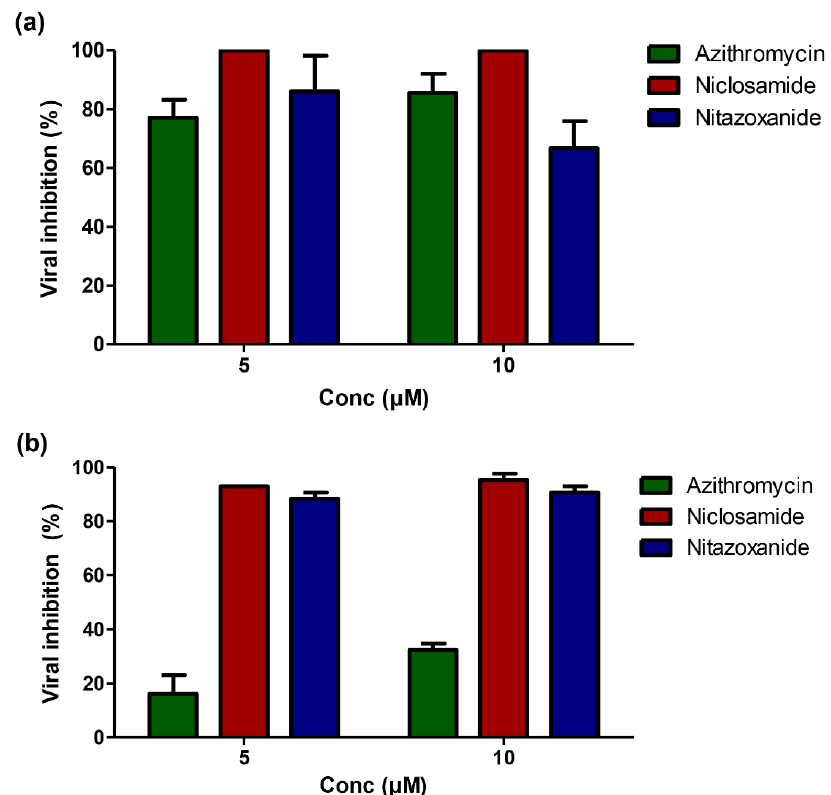
Figure 5. Di ff erential anti-SARS-CoV-2 and Anti-MERS-CoV activities for Azithromycin, Niclosamide, and Nitazoxanide. ( a ) Anti-SARS-CoV-2 activity for Azithromycin, Niclosamide, and Nitazoxanide, as measured by Plaque reduction assay. ( b ) Anti-MERS-CoV activity for Azithromycin, Niclosamide, and Nitazoxanide, as measured by Plaque reduction assay.